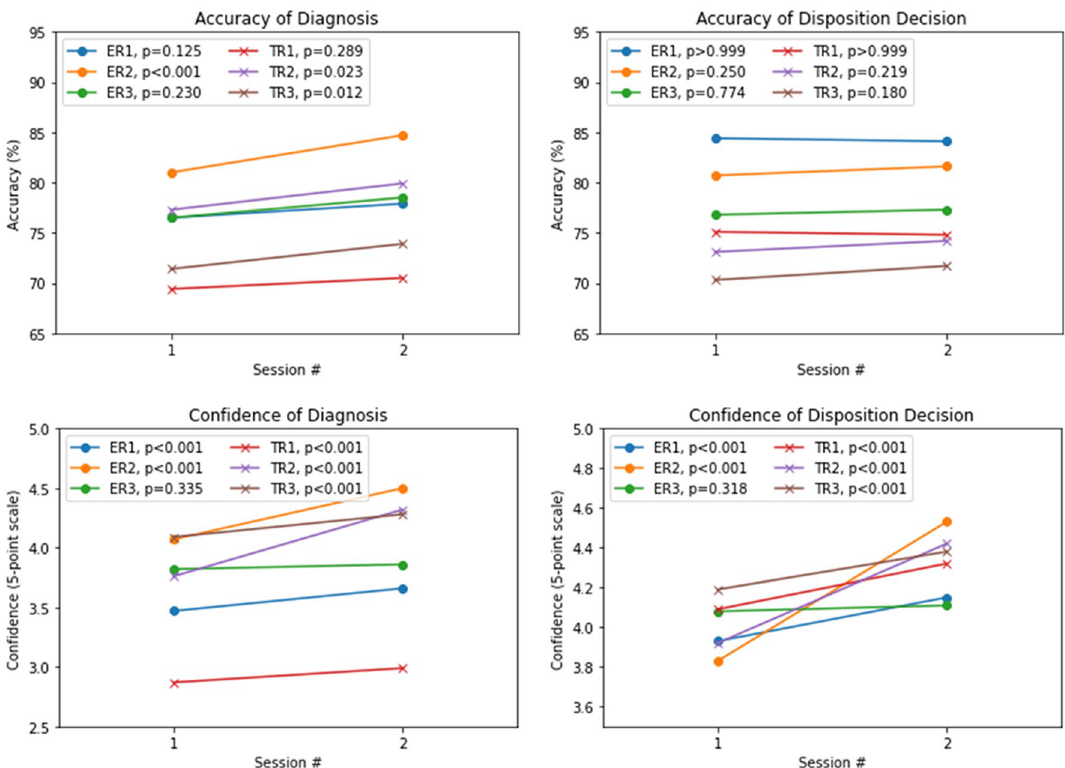
Figure 1. The accuracies and confidences of diagnosis and disposition decisions in each radiologist in 1st and 2nd sessions of image review. The accuracies of diagnosis show increasing tendency in 2nd session (statistically significant increase observed in three of the radiologists and two of the training radiologists). The accuracies of disposition decision show equivocal change between two sessions. The confidences of diagnosis and disposition decision both shows statistically significant increases in five of the six radiologists. ER, experienced radiologist; TR, training